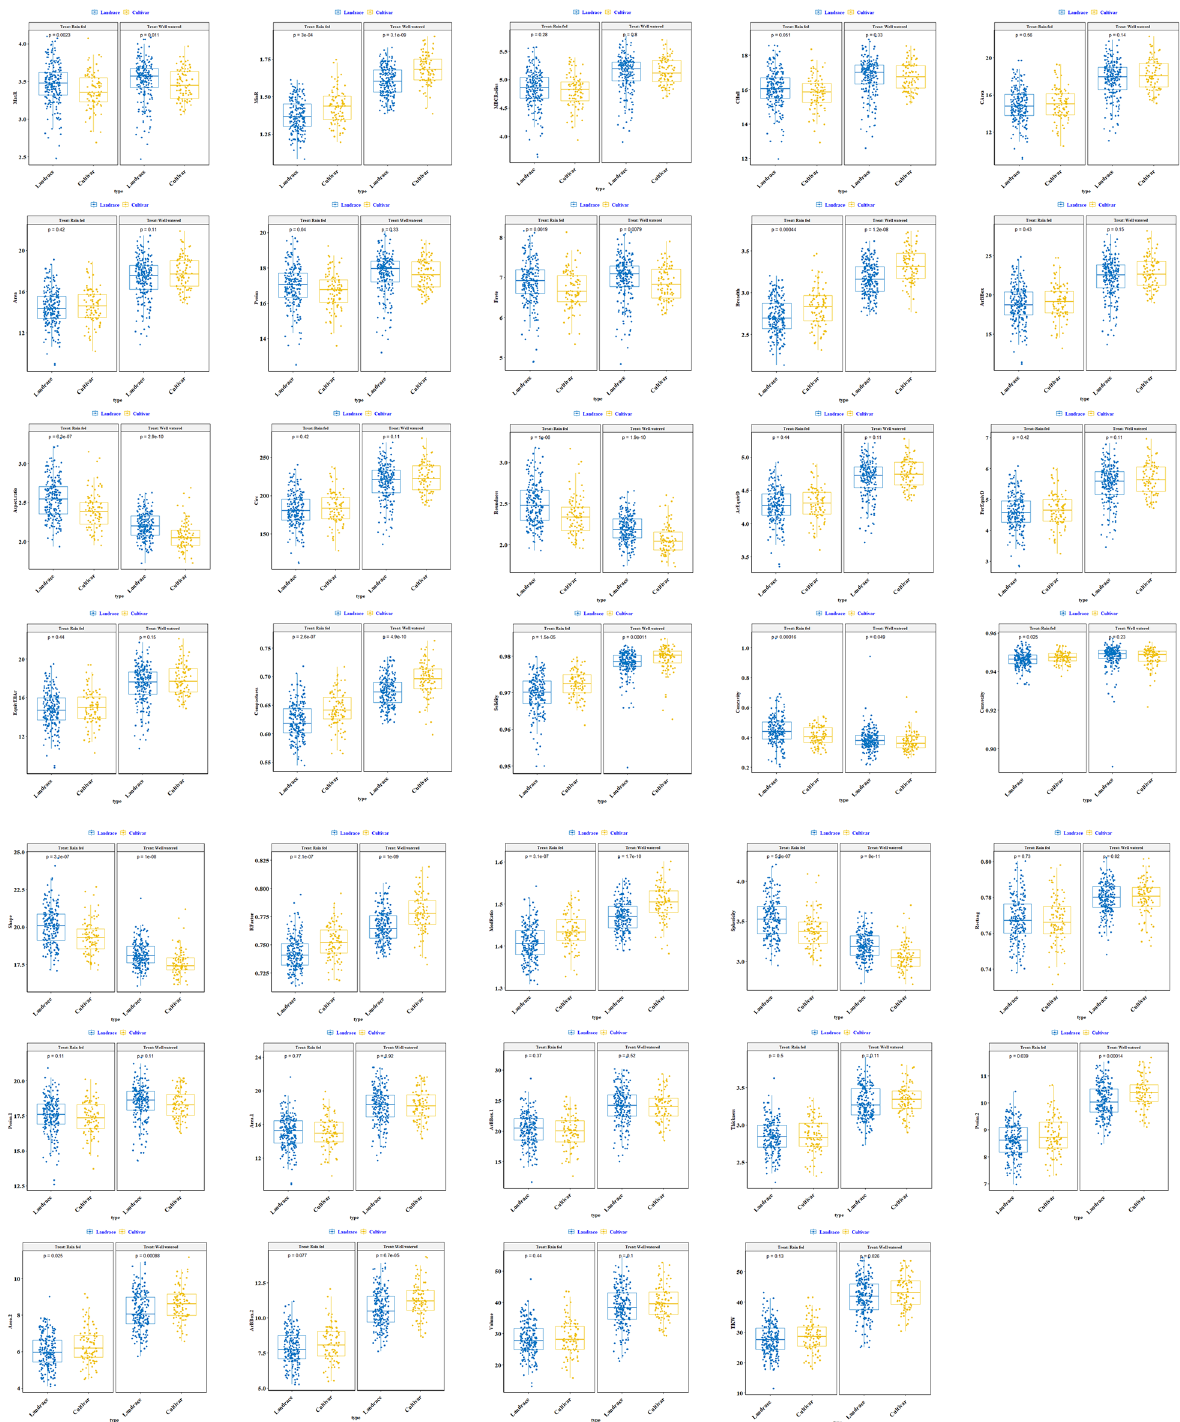
Figure 1. Box-plot representation of the distribution for a total of 34 morphometric seed traits for Iranian wheat landraces and cultivars in the well-watered and rain-fed